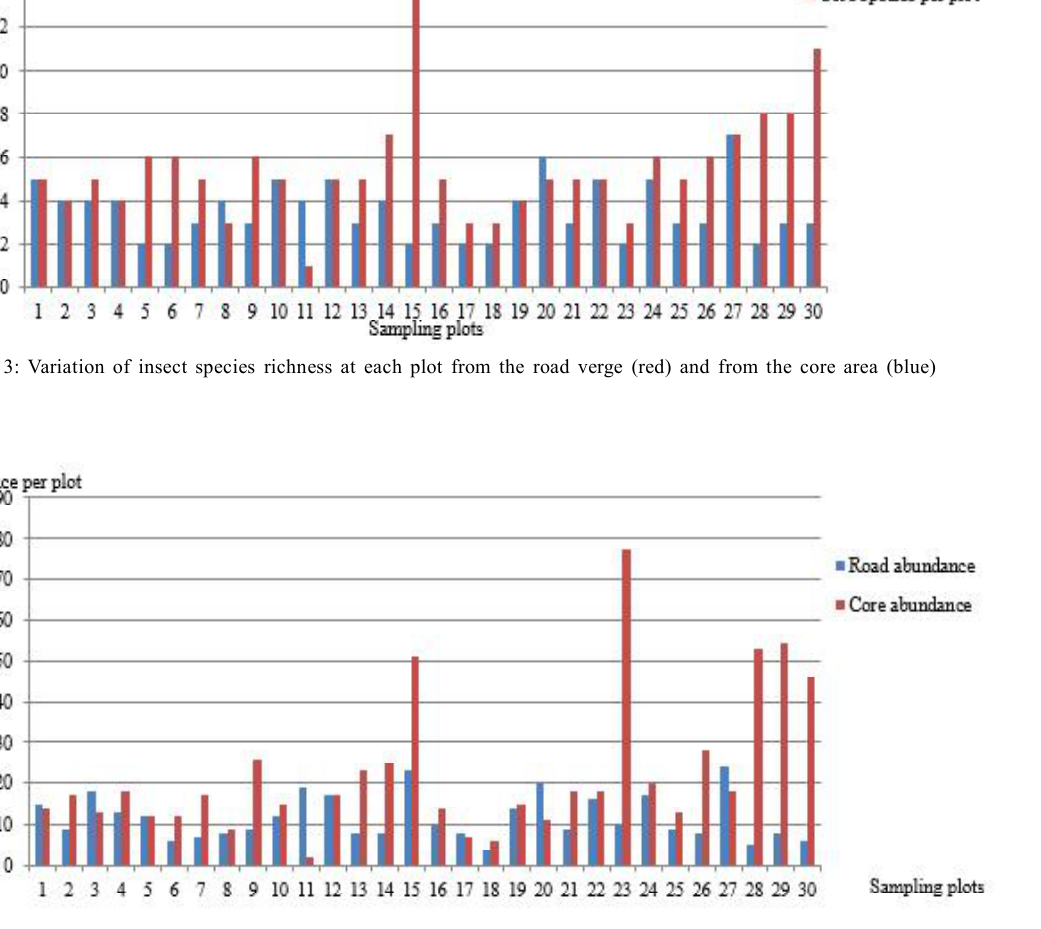
Fig. 4: Ground dwelling insect abundance at the plots of the core area (red) is higher than the abundance at the plots from the road verge site